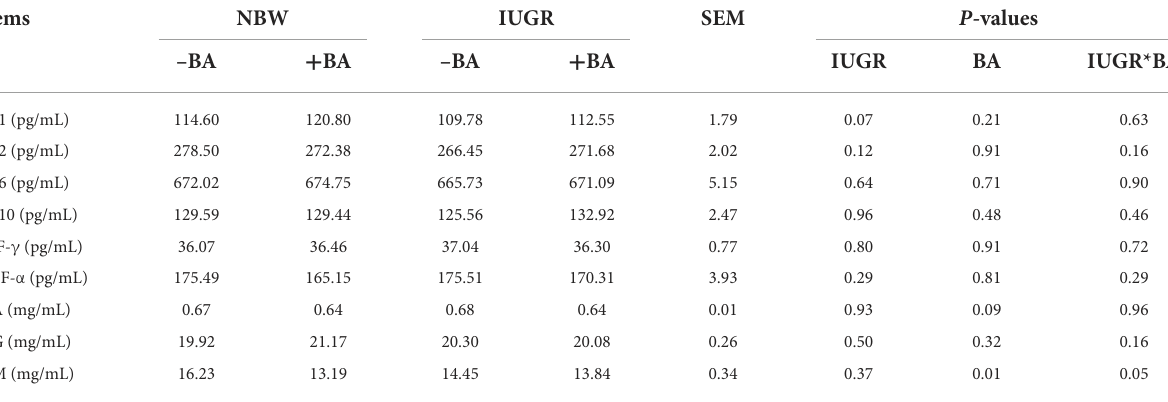
TABLE 3 Effects of dietary bile acid (BA) supplementation on plasma cytokine and immunoglobulin of weaned piglets with NBW and IUGR. Items NBW IUGR